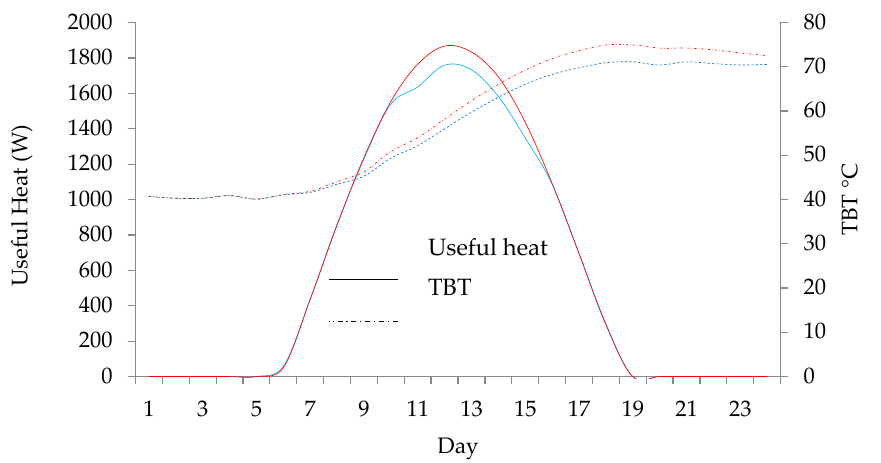
Figure 4. (Left) Profiles of the useful heat transfers from the solar collector to the charging tank for the highest (red) and lowest (blue) solar radiation days. (Right) Charging tank brine temperature profiles for the highest (red) and lowest (blue) solar radiation days.